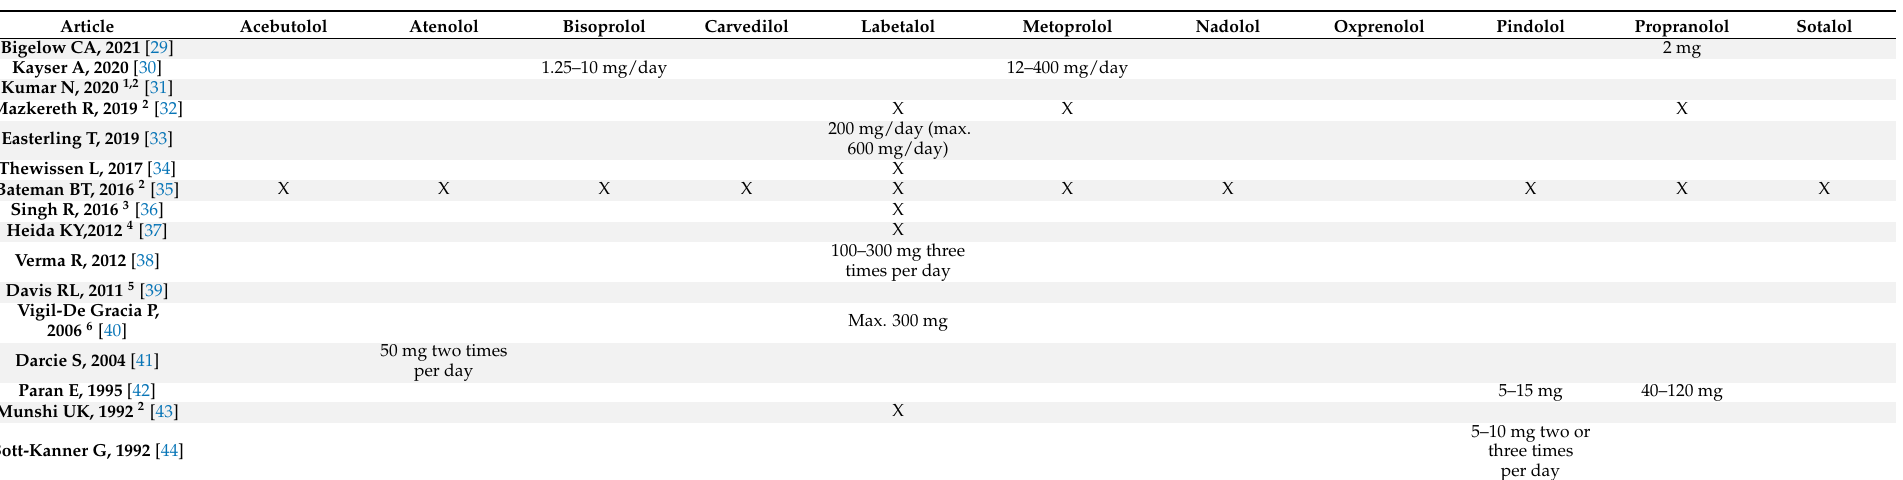
Table 3. Type and dosage of beta